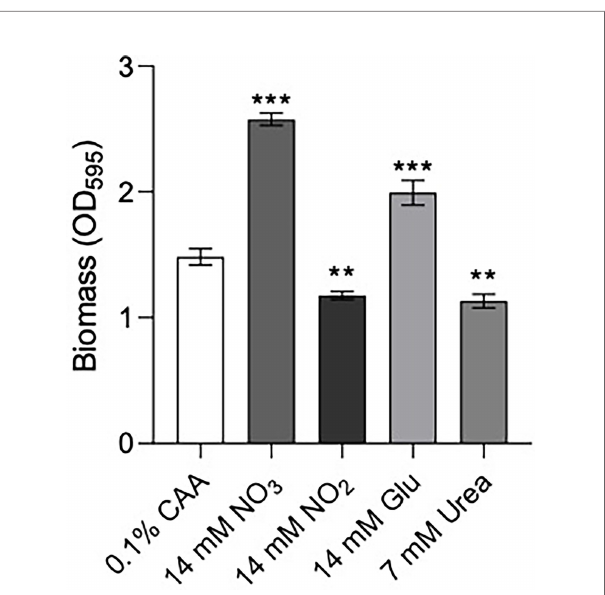
FIGURE 4 | Bio fi lm formation of P. aeruginosa PA14 was in fl uenced by nitrogen source. Bio fi lm was formed in BM2 medium containing casamino acids (CAA), nitrate (NO − 3 ), nitrite (NO − 2 ) glutamate (Glu), or urea in equimolar amounts. 96-well polypropylene plates were inoculated with bacteria suspended in basal medium (BM2) supplemented with 0.4% glucose. 18-20 h later, biomass was stained with crystal violet and measured by scanning its OD 595 . Data reported as mean ± standard error of the mean (SEM) from three independent experiments containing 2-3 biological replicates each ( n = 6-9). ** P < 0.01, *** P < 0.001 according to Kruskal-Wallis nonparametric test followed by Dunn ’ s post-hoc